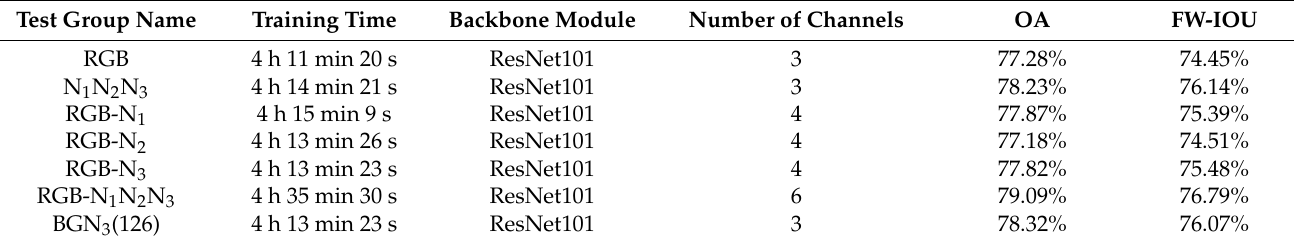
Table 7. Influence of spectral features on model